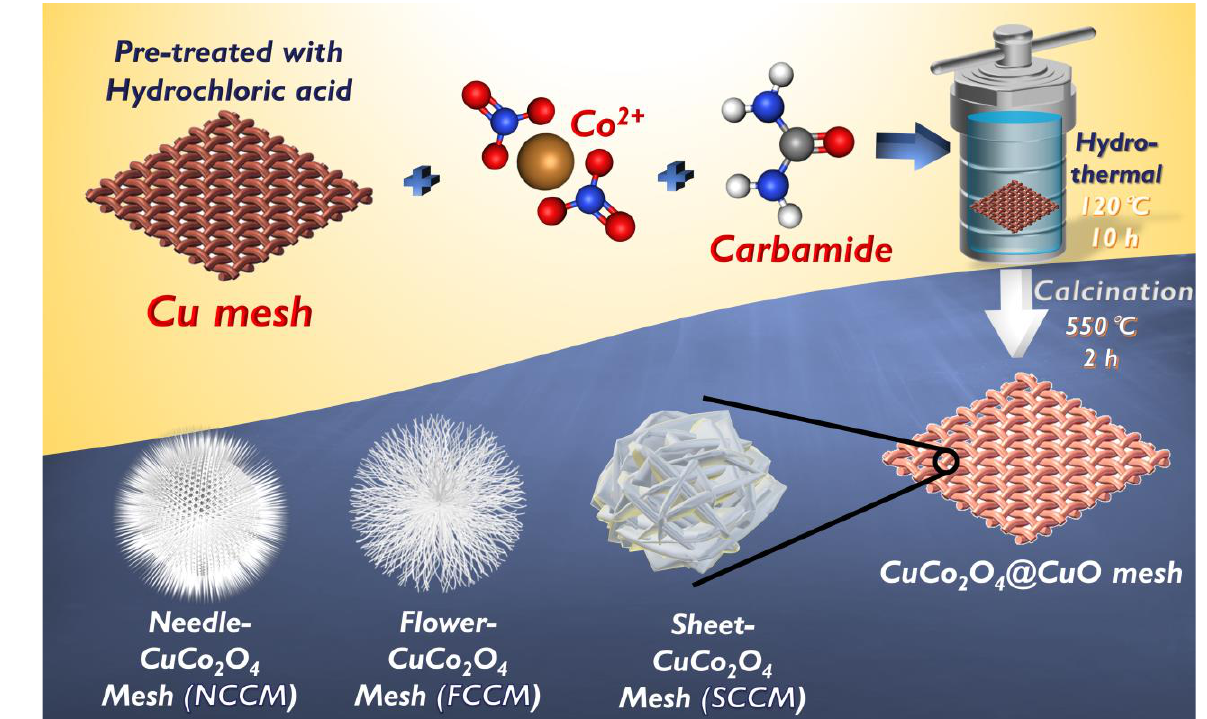
Figure 1. Preparation scheme of NCCM, FCCM, and SCCM.